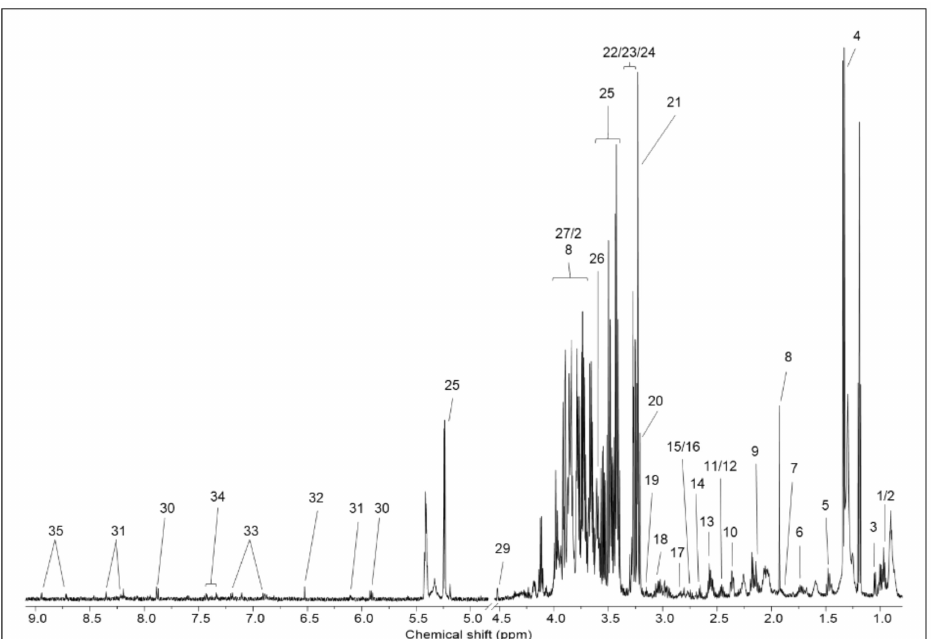
Figure 3. Representative 600 MHz 1H NMR spectra of the liver. Key: 1, isoleucine; 2, leucine;